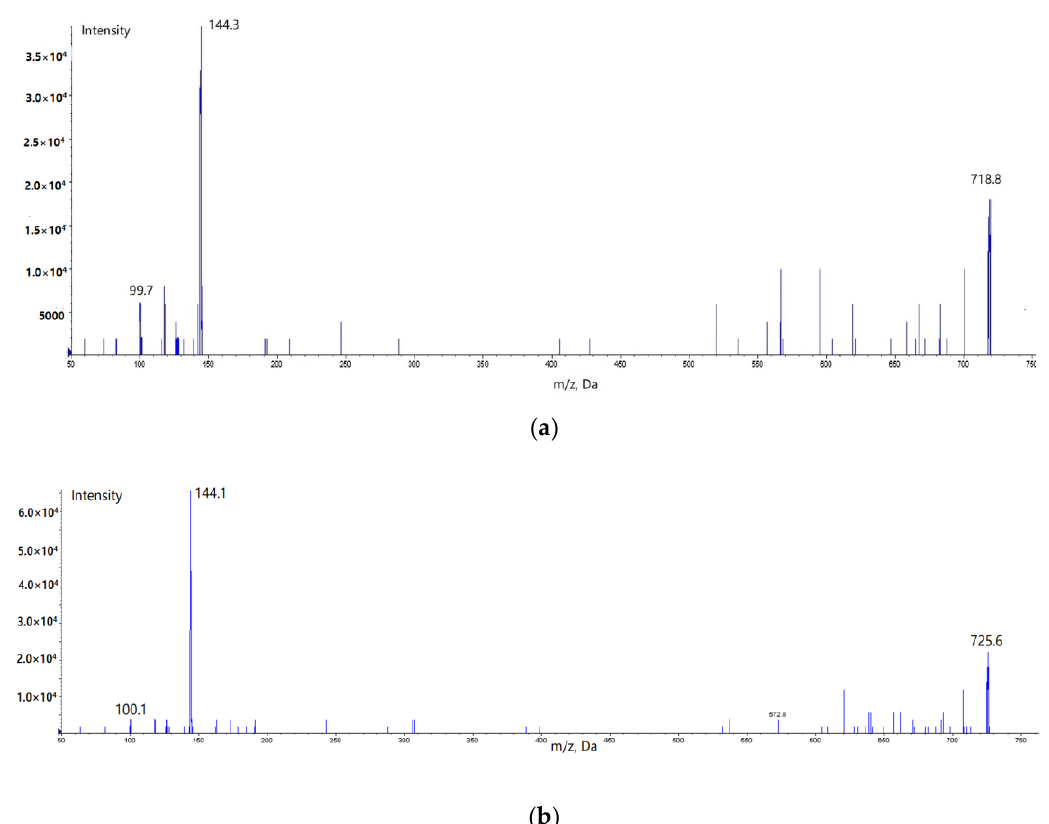
Figure 2. Product ion mass spectra of [M + H] 2+ for ( a ) vancomycin (718.8 → 144.3, 99.7) and ( b ) norvancomycin (725.6 → 144.1, 100.1).